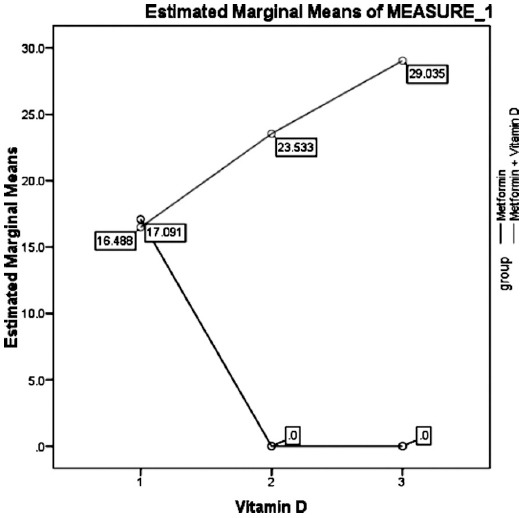
Comparison of Vitamin D in both groups at different follow-ups. Repeated measurements ANOVA was applied p-value = 0.000 (Significant)